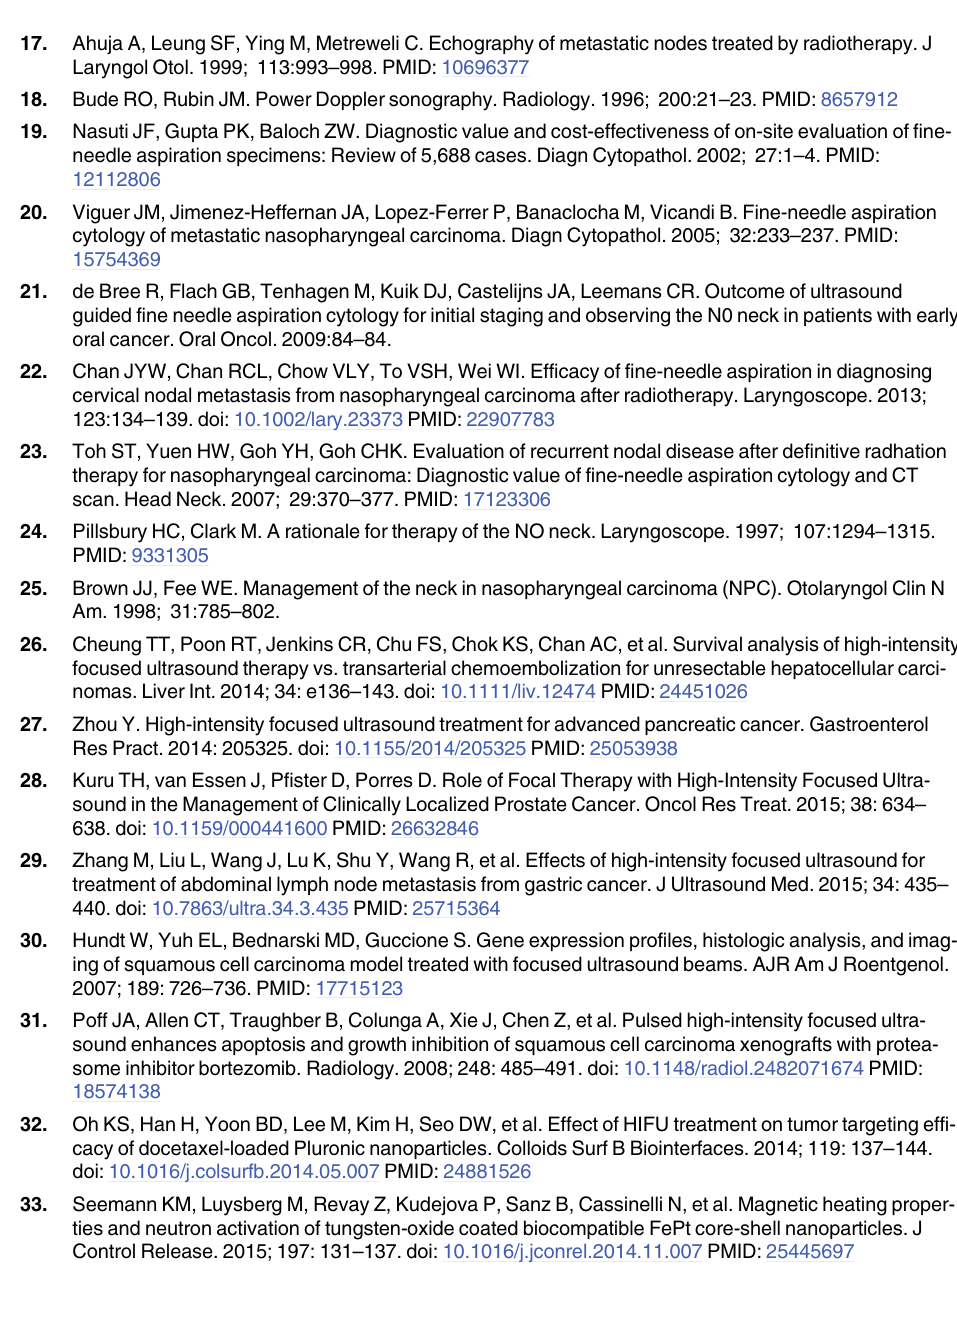
PLOS ONE | DOI:10.1371/journal.pone.0149346 March 8,